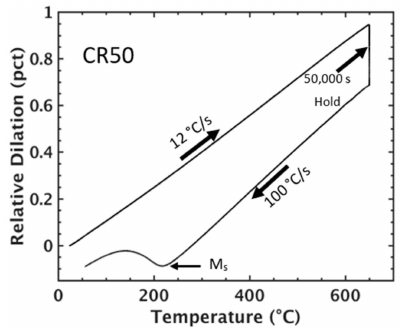
Figure 3. Dilation response of the CR50 condition during heating and isothermal holding at 650 ◦ C for 50,000 s followed by quenching to 30 ◦ C at 100 ◦ C / s.